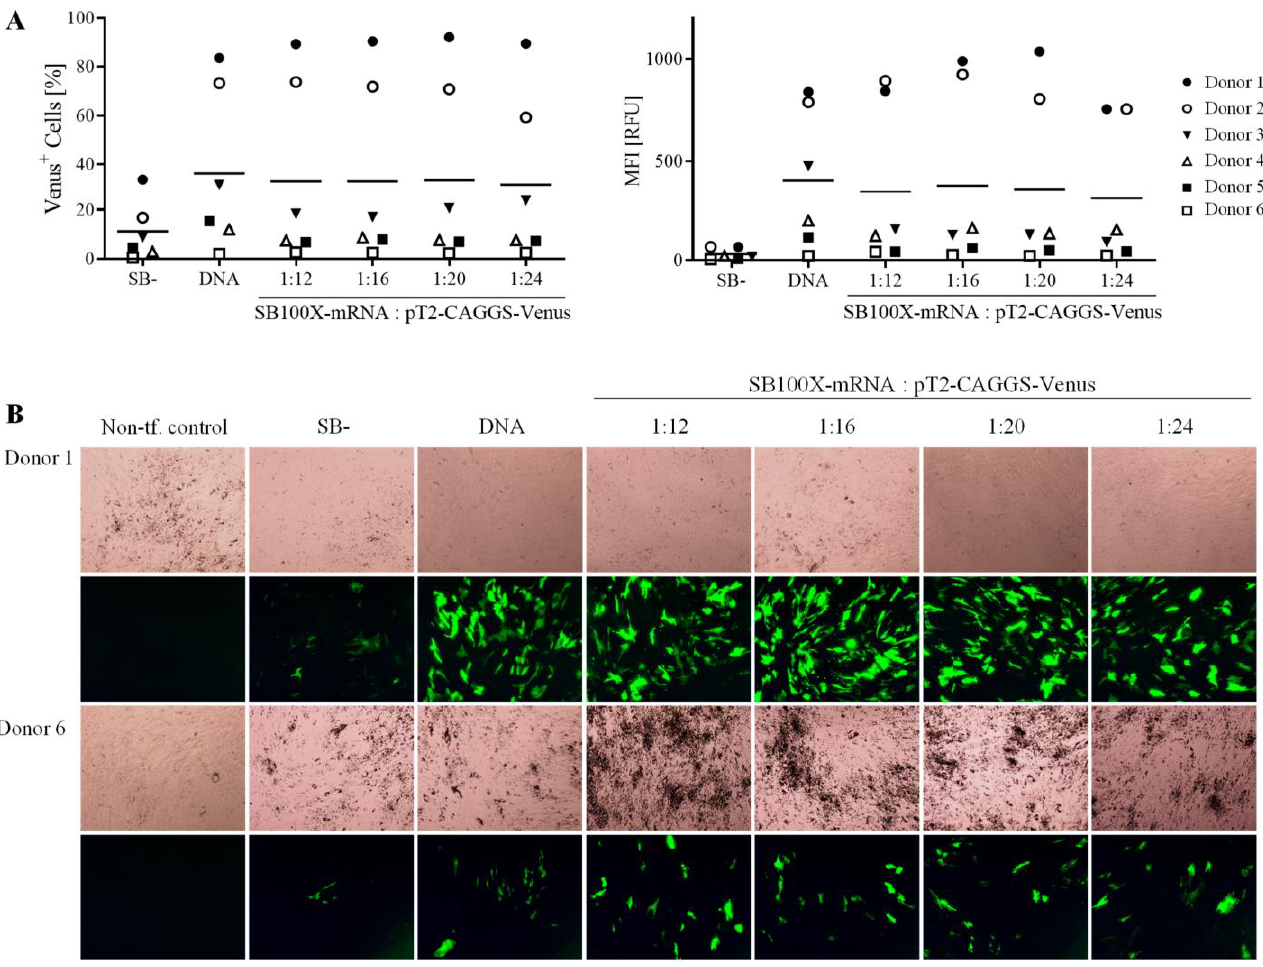
Figure 6. Analysis of primary human RPE cells transfected with pT2-CAGGS-Venus and SB100X delivered as mRNA using different transposon:transposase ratios. hRPE cells from 6 different donors (donor age 68.2 ± 7.9 years, 4 males and 2 females, post-mortem time 40.0 ± 22.9 h, cultivation time between isolation and transfection 24.7 ± 11.1 days) were transfected with different ratios of the pT2-CAGGS-Venus plasmid and SB100X-mRNA using electroporation. An inactive transposase was used as negative control, and SB100X-DNA was used as positive control at a ratio of 1:16. ( A ) Confluent cultures were analyzed by flow cytometry at 10–14 days after transfection. The percentage of Venus-positive cells (left graph) and the MFI (right graph) were analyzed for each individual donor (dots), and the mean for all donors was calculated (line). ( B ) Fluorescence and brightfield micrographs of confluent cultures show the variability in the number of transfected cells in Donor 1 and Donor 6, respectively (Scale bar: 500 μm).